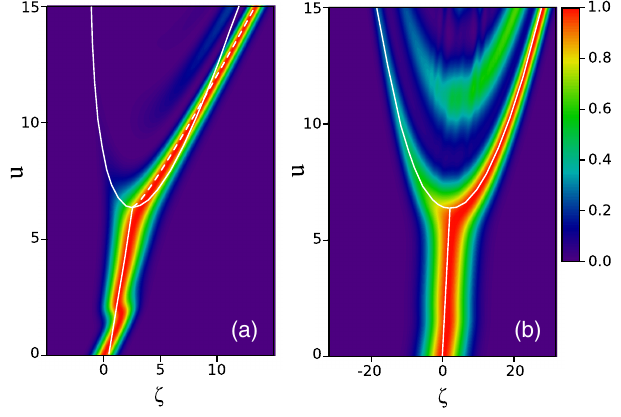
FIG. 1. Radiation power vs ζ ; u for two different initial conditions, (a): σ ζ 0 ¼ 0 . 82 , (b): σ ζ 0 ¼ 5 . The continuous white line represents Eq. (1), where the u position was set to match the s saturation splitting position. The white line represents the peak ¼ 1 = 3 before saturation, and position, drifting with velocity v e splitting for u > u into the two roots of Eq. (4). The white s ð u Þ . See text for more dashed line for u > u is the function ζ þ s c